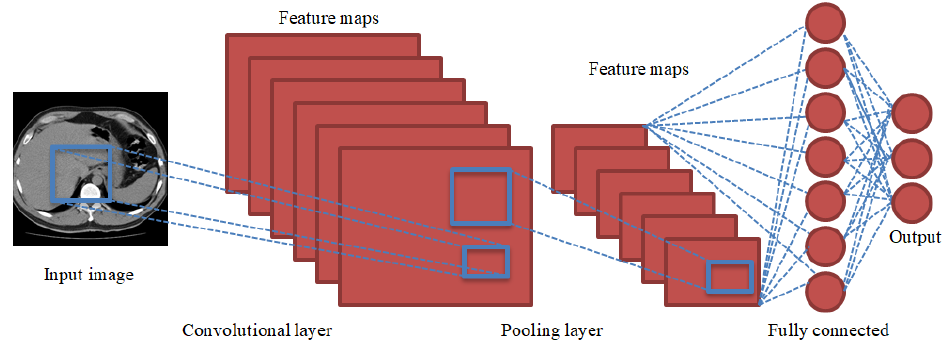
Figure 1. Conventional artificial neural network (ANN) architecture.